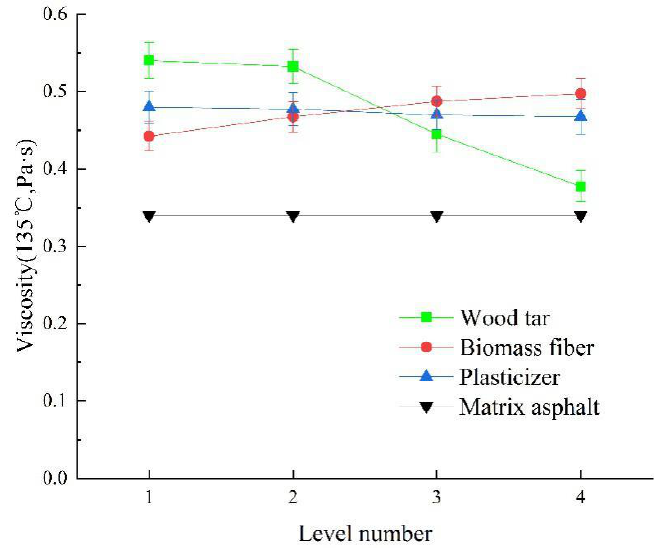
Figure 8. Change rule of viscosity of wood tar-based rejuvenated asphalt under di ff erent factors and levels.